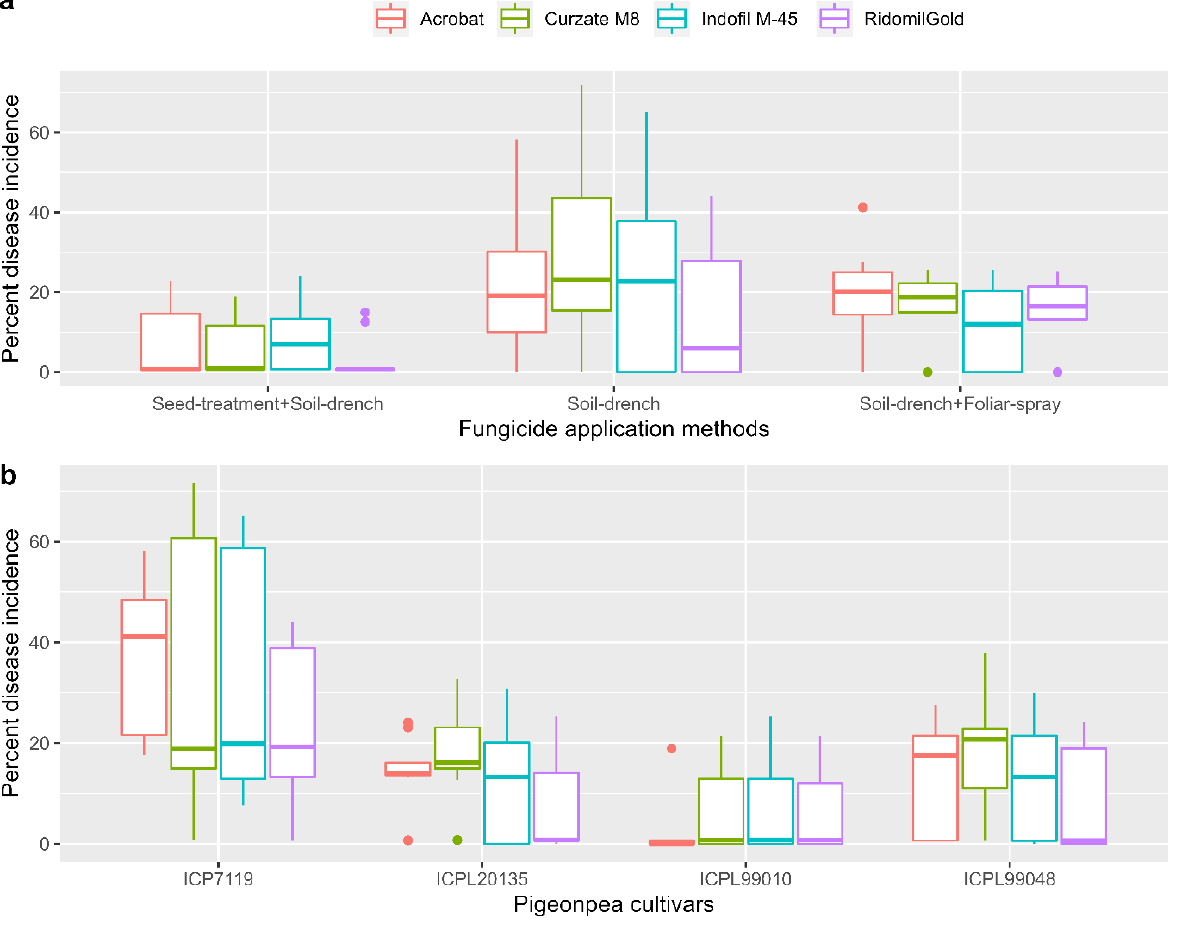
Figure 5. Evaluation of different fungicides and fungicide application methods for controlling the Phytophthora blight in different pigeonpea cultivars. ( a ) Fungicide application methods; ( b ) different pigeonpea cultivars.